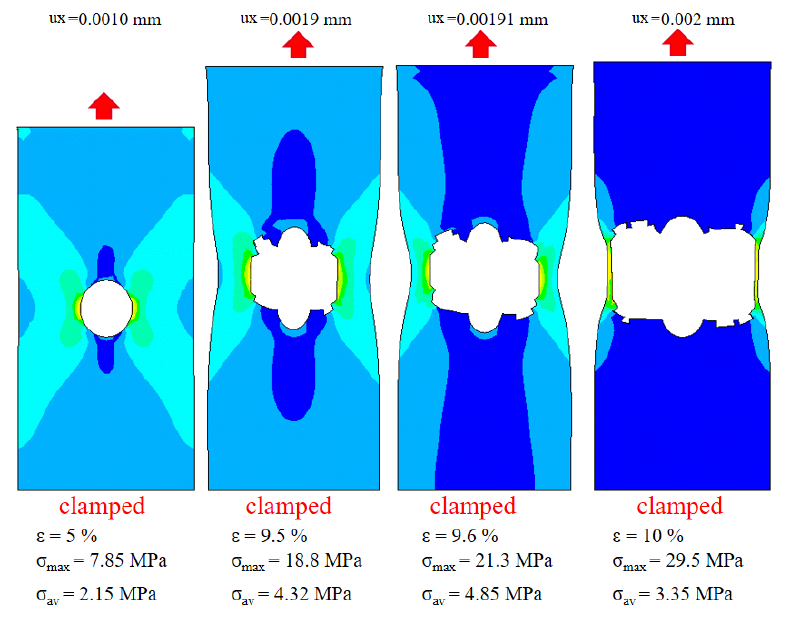
Figure 20. Simulated damage of a leather sample near a hole under vertical tension modelled using solid elements.